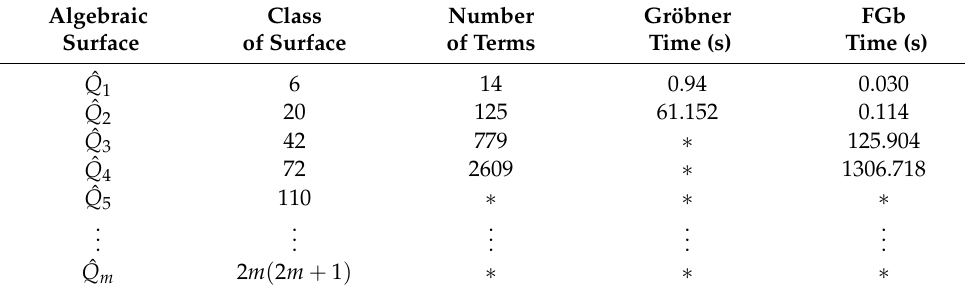
Table 2. Results for the Enneper algebraic maximal surfaces ˆ Q m ( a , b , c ) = 0. Algebraic Class Surface of Surface